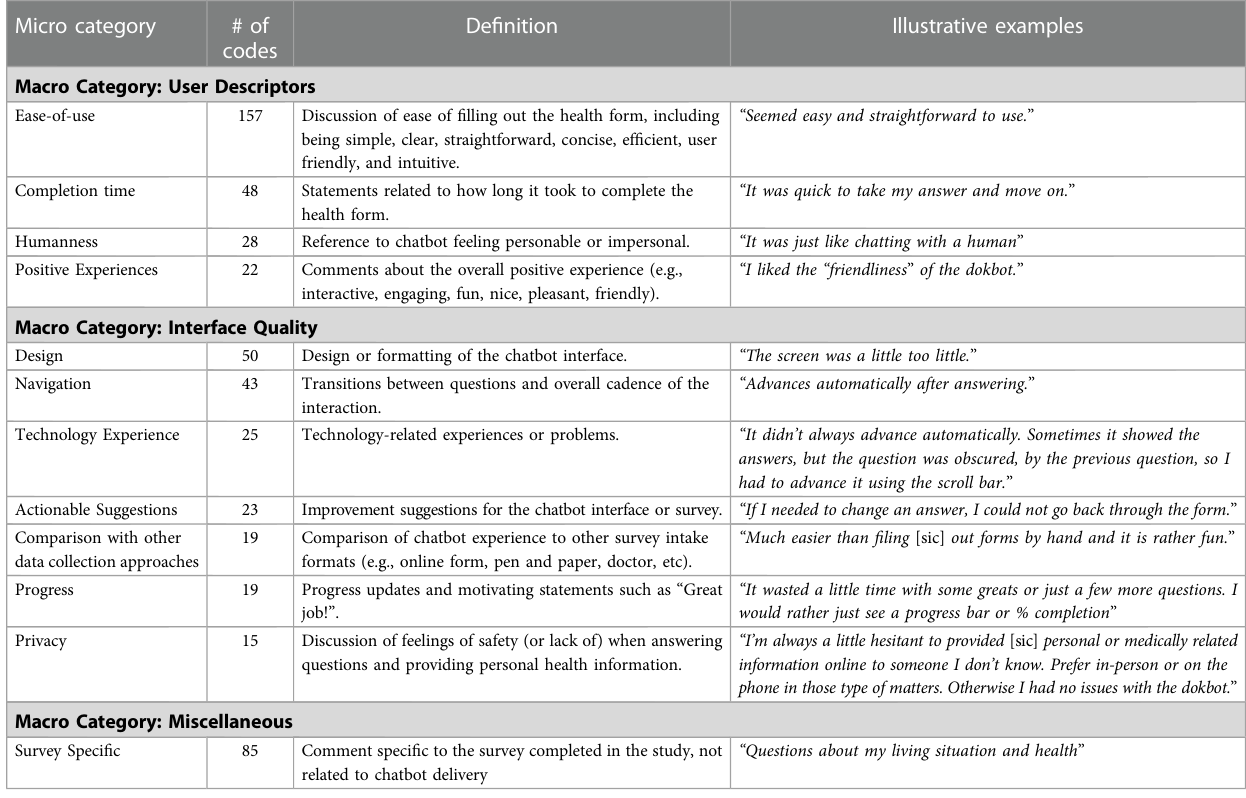
TABLE 5 Themes and codebook: older adults ’ likes and dislikes about chatbots.